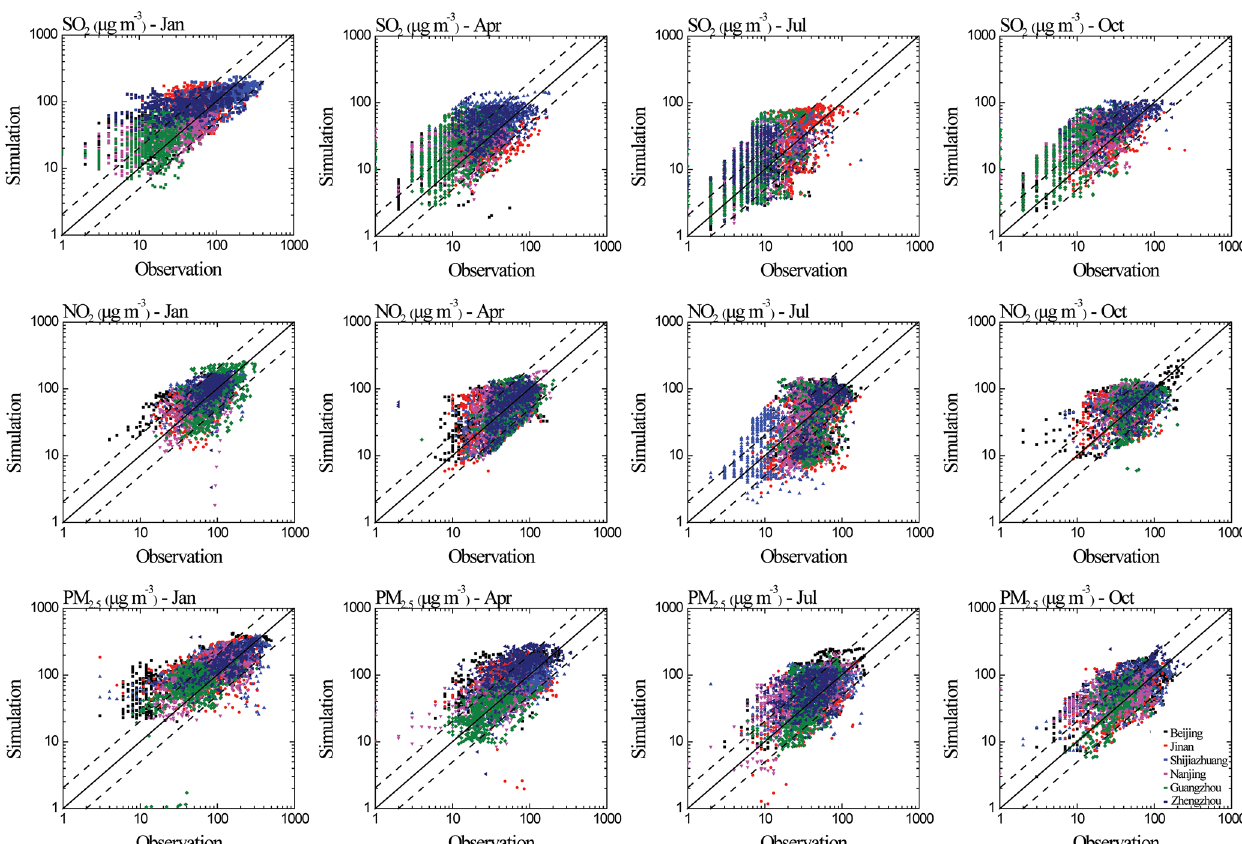
Figure 2. The scatterplots between the modeled and the observed hourly SO 2 , NO 2 , and PM 2 . 5 in January, April, July, and October 2015. The solid lines are 1:1, and the dashed lines are 2:1 or 1:2.